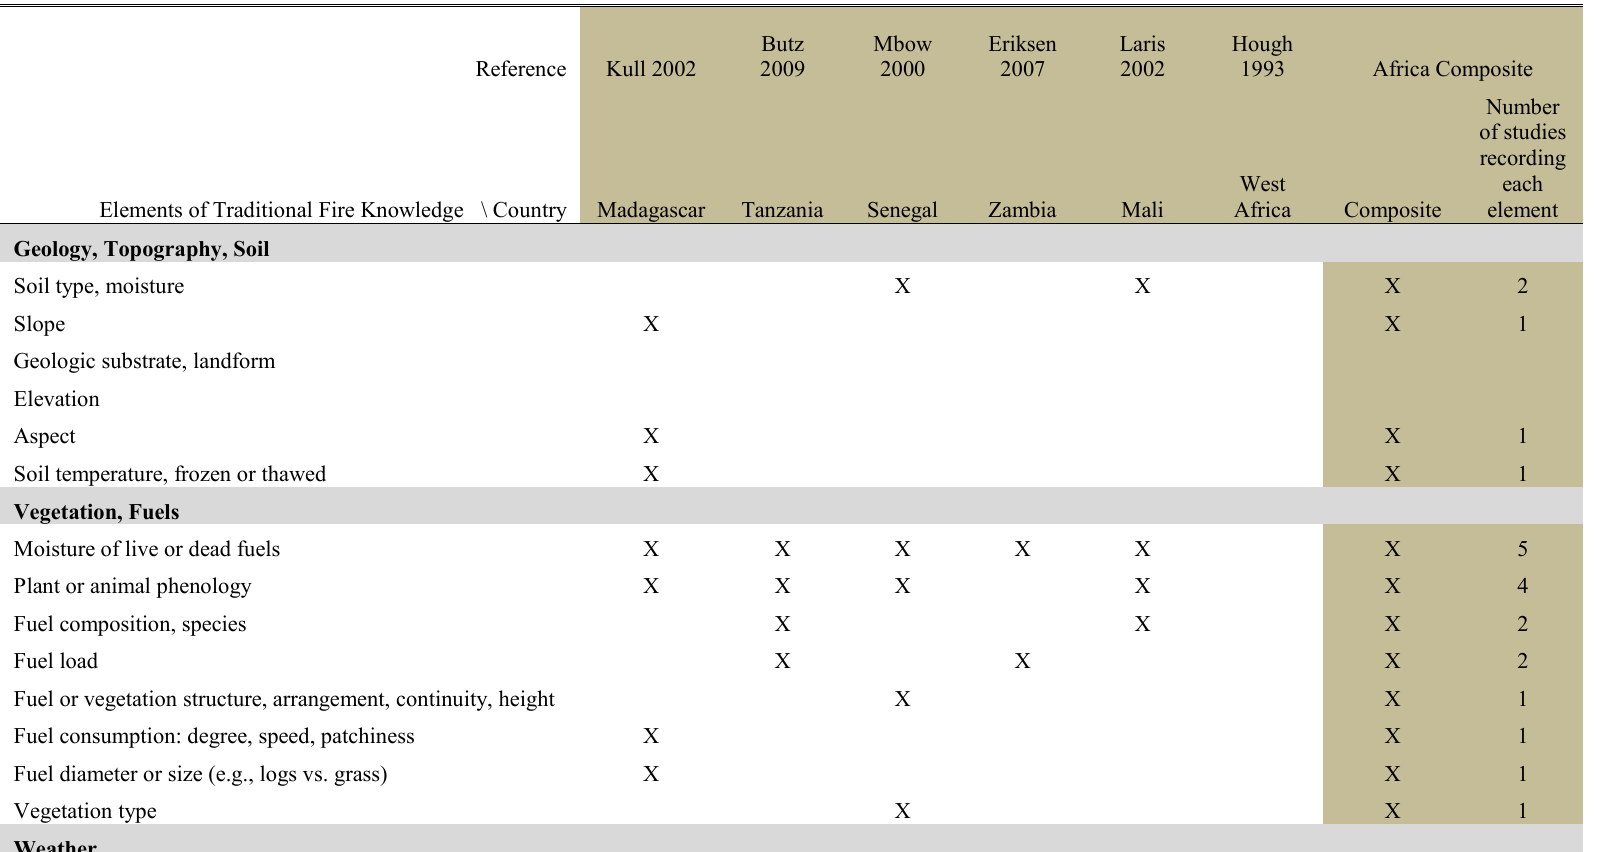
Table A.1. Elements of traditional fire knowledge recorded in studies from Africa